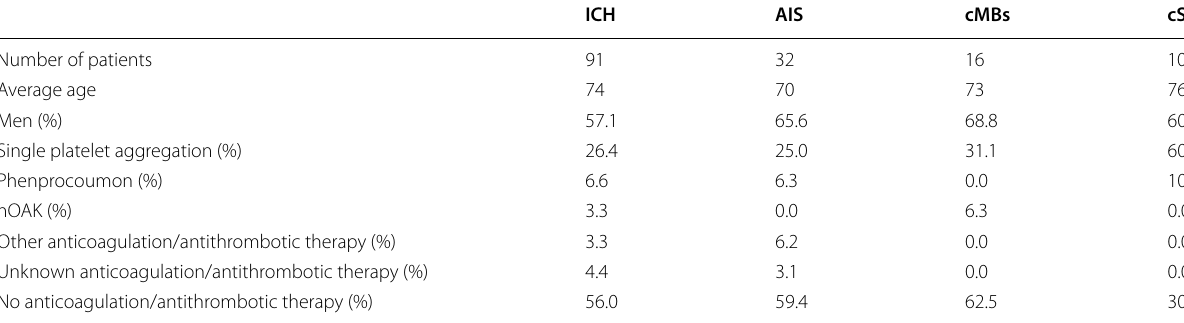
Table 1 Basical clinical patient information for the four